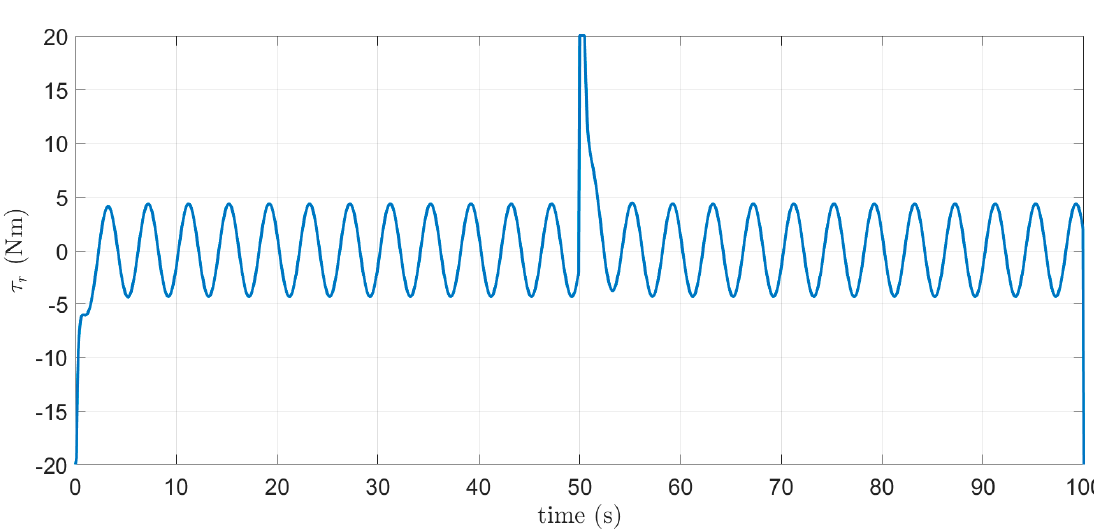
Figure 11. Simulation results of parameter adaptation without robust action. 4.2. Robust Adaptive Heading Control Under the same conditions of the simulation of applying adaptive heading control in the previous subsection, the robust adaptive control was used as described in Equation (25). The constant boundary was chosen as 𝜙 = 0.04 . The performance of the robust adaptive heading control is shown in Figure 12. In the presence of external disturbances, the heading angle is regulated well along the desired heading angle, as shown in Figure 12a. The yaw rate also converges to zero following the virtual input in Figure 12b. Due to the small boundary layer 𝜙 , the chattering appears quickly at the beginning of the regulation task. In Figure 13, the control input has similar smoothness to Figure 10, but this input can minimize the external disturbance well.